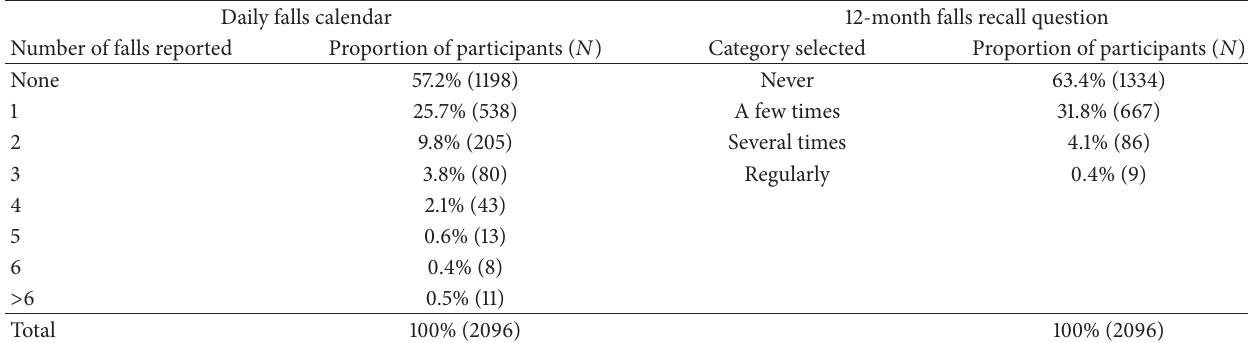
Table 1: Proportion of participants by number of falls.